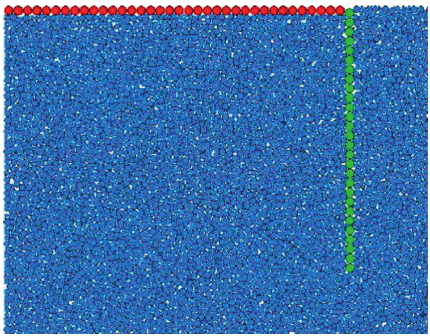
Figure 2: The initial state of the model.